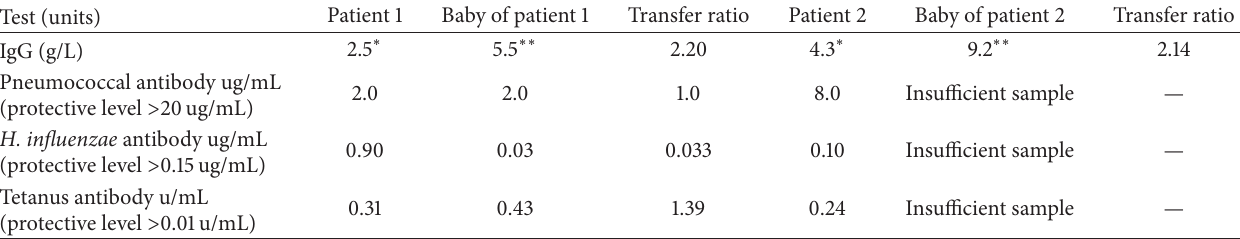
Table 1: Summary of serum/cord blood total IgG and specific IgG levels against pneumococcal polysaccharides, H. influenzae b, and tetanus toxoid in patients and their